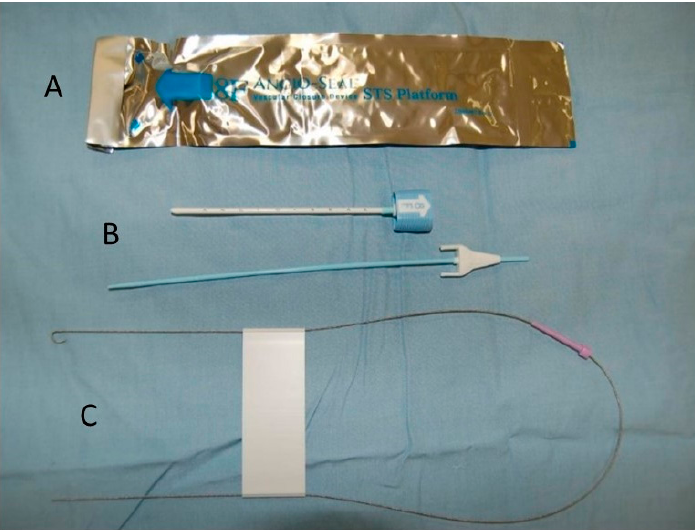
Figure 3. Angio-Seal arterial puncture closure device commercial kit, including: Angio-Seal VIP device ( A ), insertion sheath and dilator ( B ) and 0.035” stainless steel guidewire ( C ).